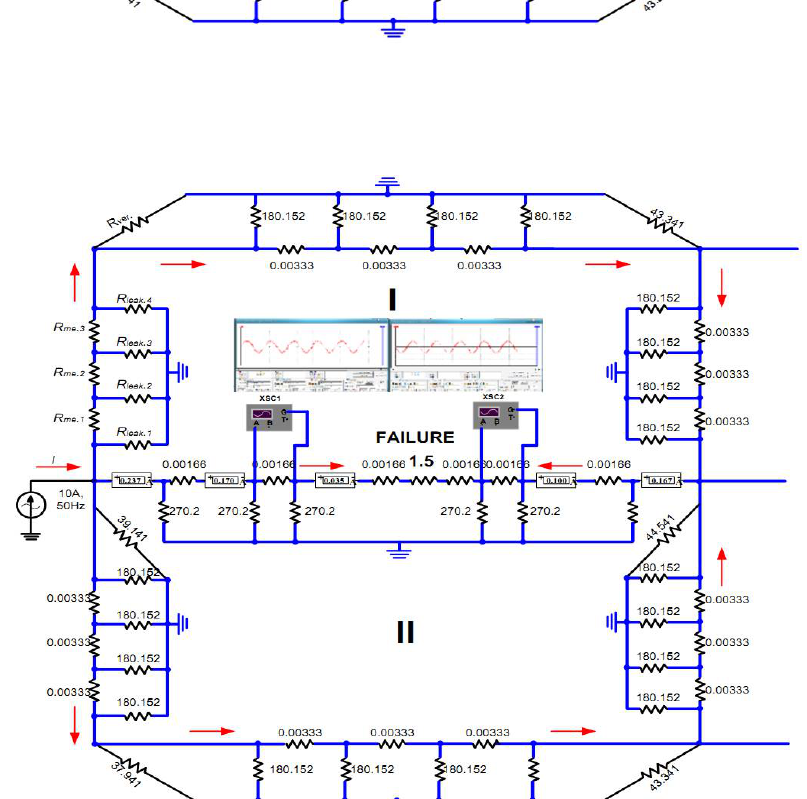
= 0Ω and (b) R = 1 . 5Ω